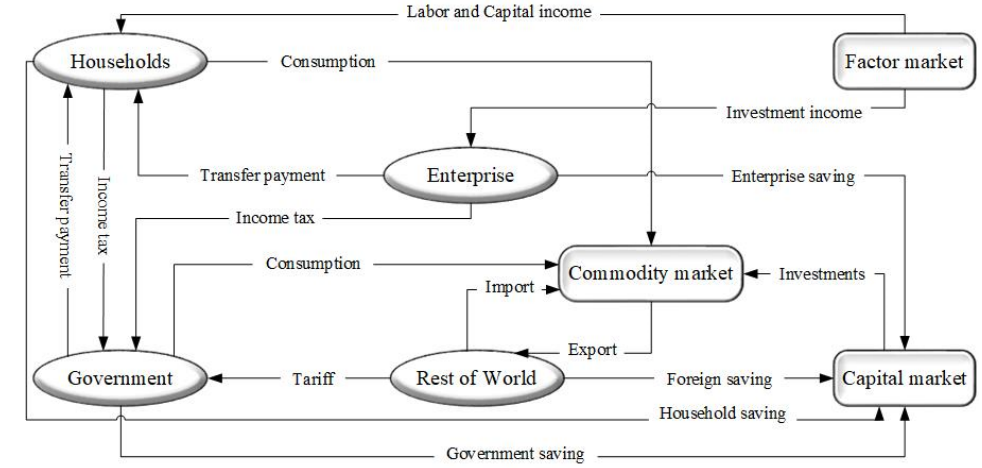
Figure 1. Skeleton of proposed CGE model.